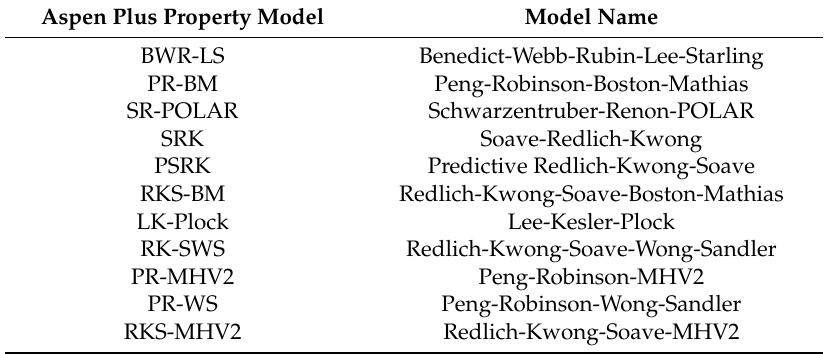
Table 1. Potential thermodynamic property models in Aspen Plus for the